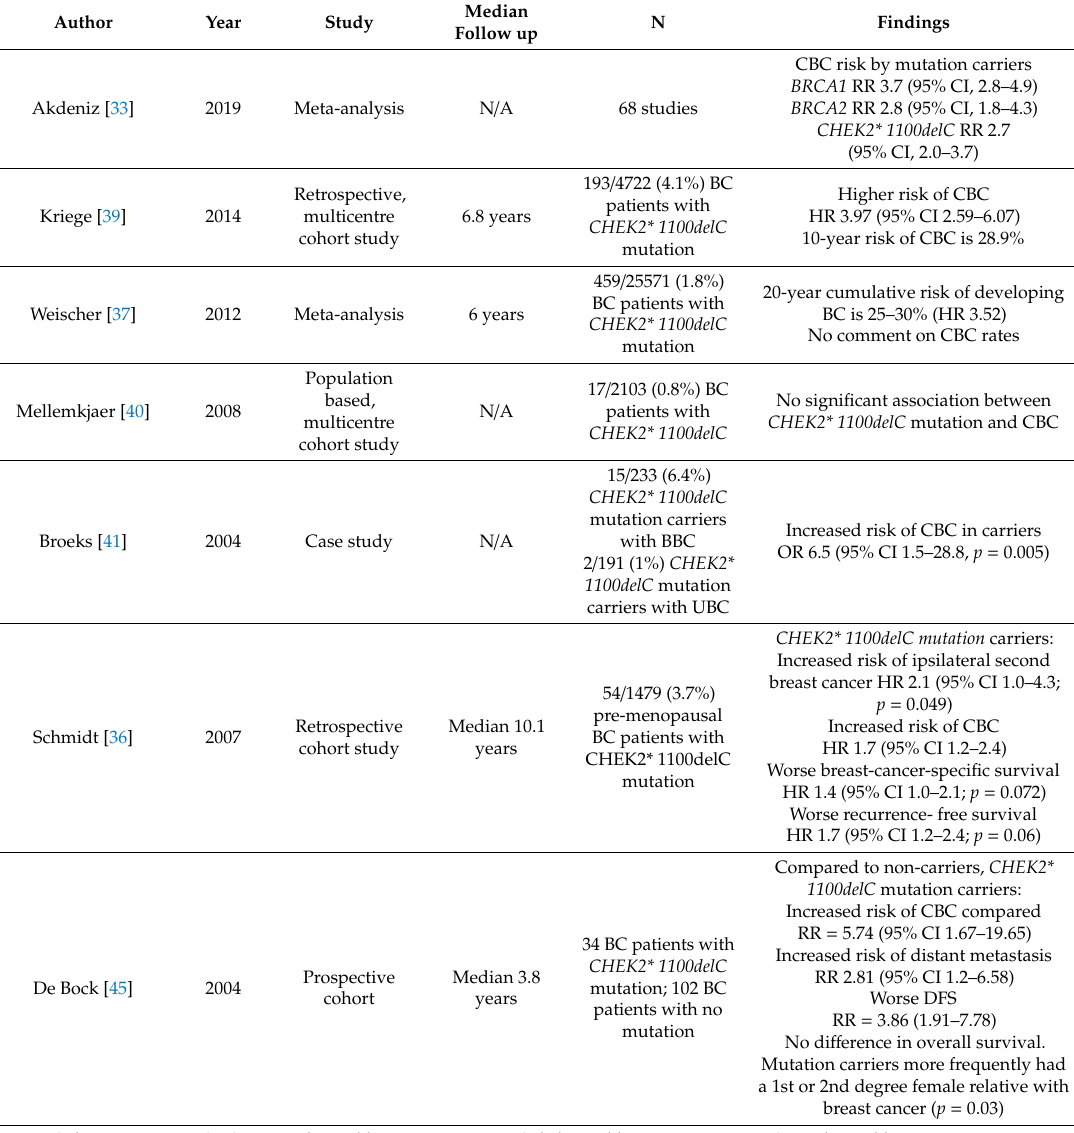
Table 2. Studies looking at CBC risk and survival in CHEK2* 1100delC mutation